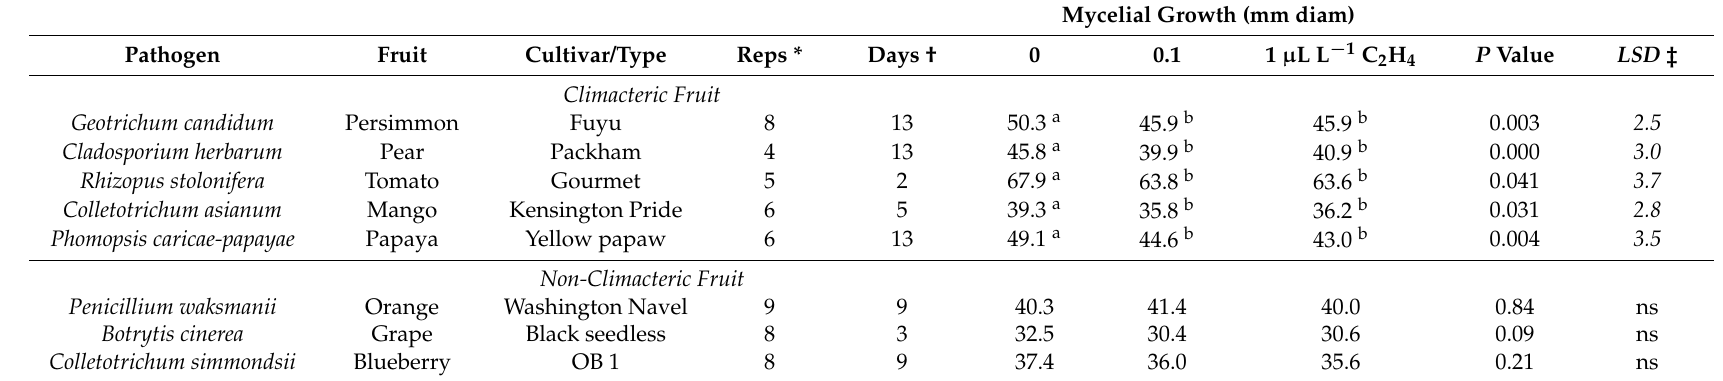
Mycelial Growth (mm